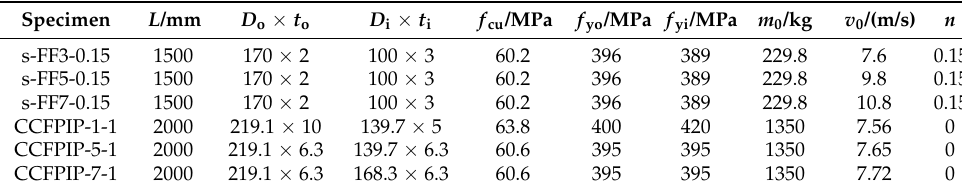
Table 3. The specimens for verification.